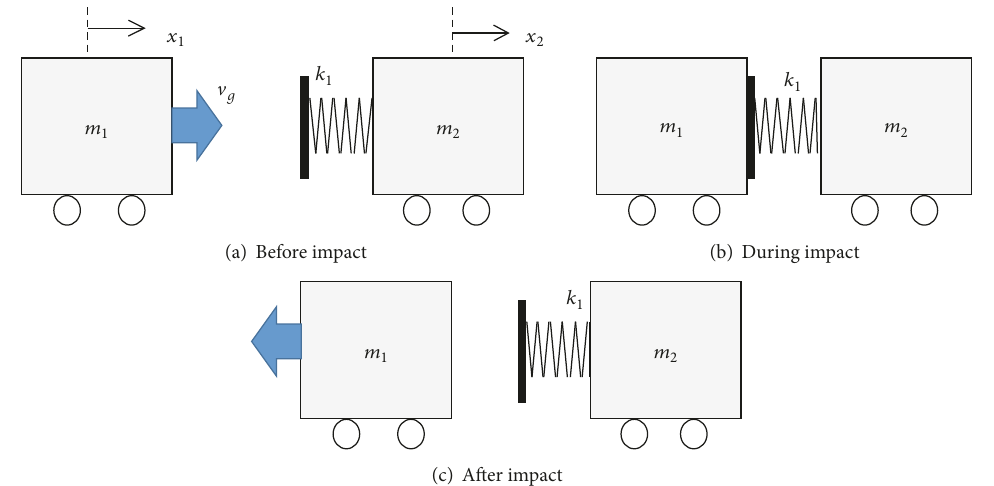
Figure 3: Simplified model of impact testing system for 1st shock-wave.